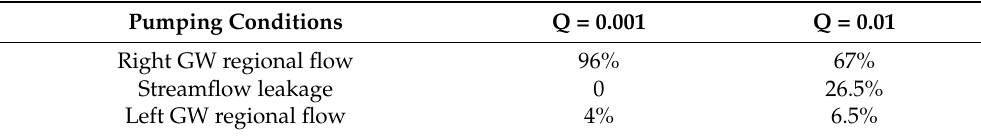
Table 3. Flow proportion reaching the pumping wells at Ar = 1, with the head gradient configuration H0 and SB0 for different pumping rates.